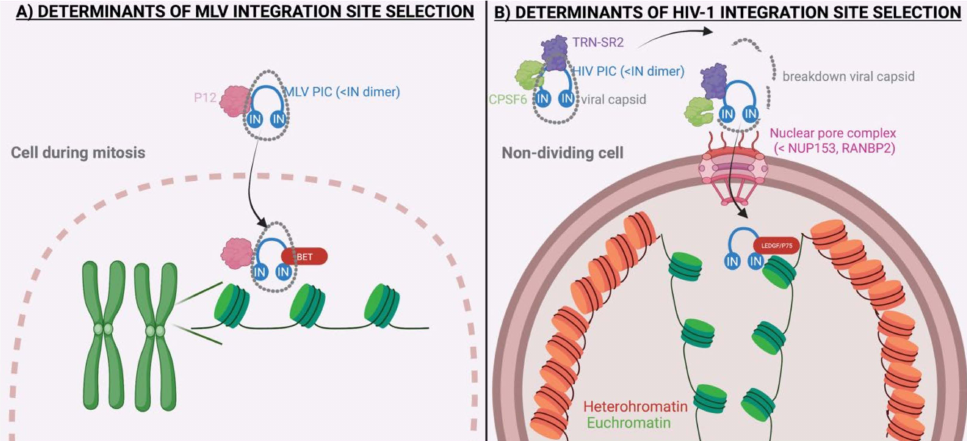
Figure 3. ( A ) Determinants of the murine leukemia virus (MLV). MLV tends to integrate near